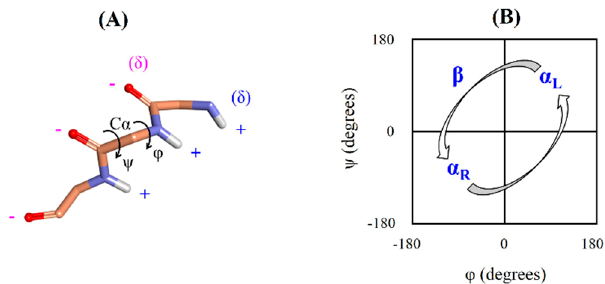
Figure 1. ( A ) The α -strand structure. Backbone atoms of the α -strand forming residues are displayed by the stick model. Side chains and non-polar hydrogen atoms are not shown for the sake of clarity. Alignment of main chain carbonyls on one side of the α -strand and the amide NH groups on the other side leads to two edges with opposite charges. Phi ( ϕ ) represents C-N-C α -C dihedral angle and Psi ( ψ ) represents N-C α -C-N dihedral angle. ( B ) Ramachandran or ( ϕ , ψ ) plot. The α R indicates right-handed helical region, α L indicates left-handed helical region and β indicates β -sheet region. The α -strand consists of successive residues with alternating dihedrals in the α R and α L regions.